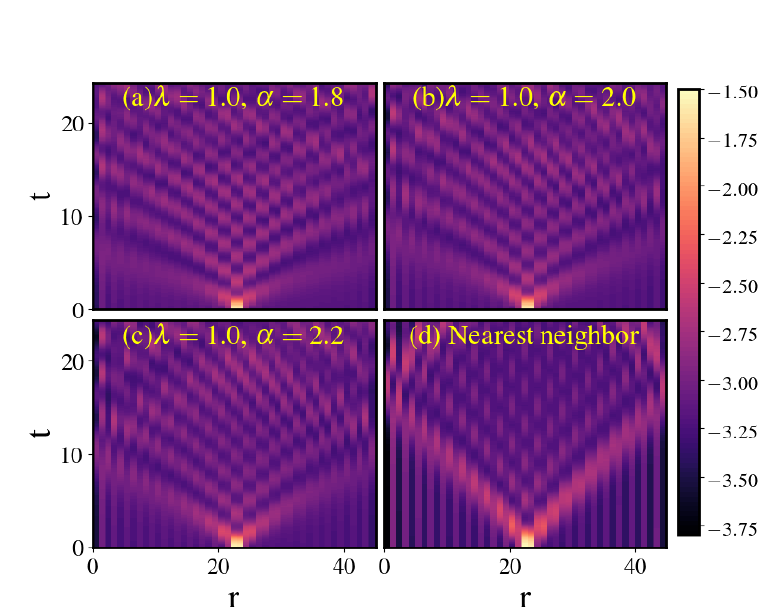
Figure 7: Domain wall expansion for λ = 1 and different values of α , obtained with tDMRG for a chain with L = 48 spins. Results for the nearest neighbor case are also included. We show the “spinons density”: 〈 N ↑ ( r , t ) N ↑ ( r + 1, t ) 〉 . Color density is in a log